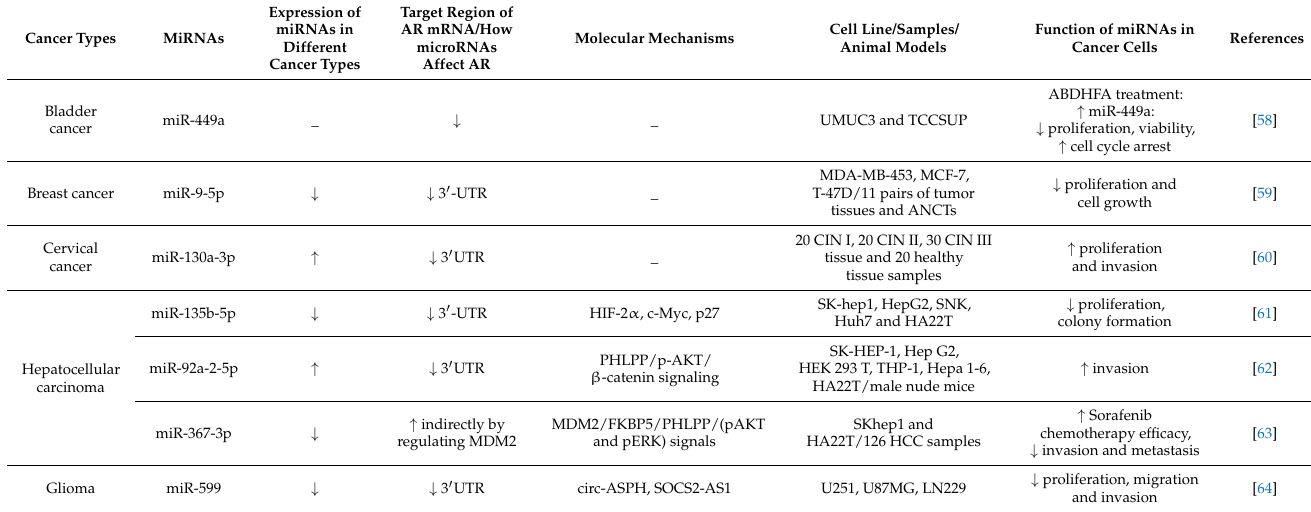
of prostate cancer. Detailed information about these miRNAs is presented in Table 1. ( reduction or inhibition of, in- creased levels of, Table 2. Effects of miRNAs on AR in different cancer types ( ↓ : decrease in, ↑ : increase in). CancerTypes